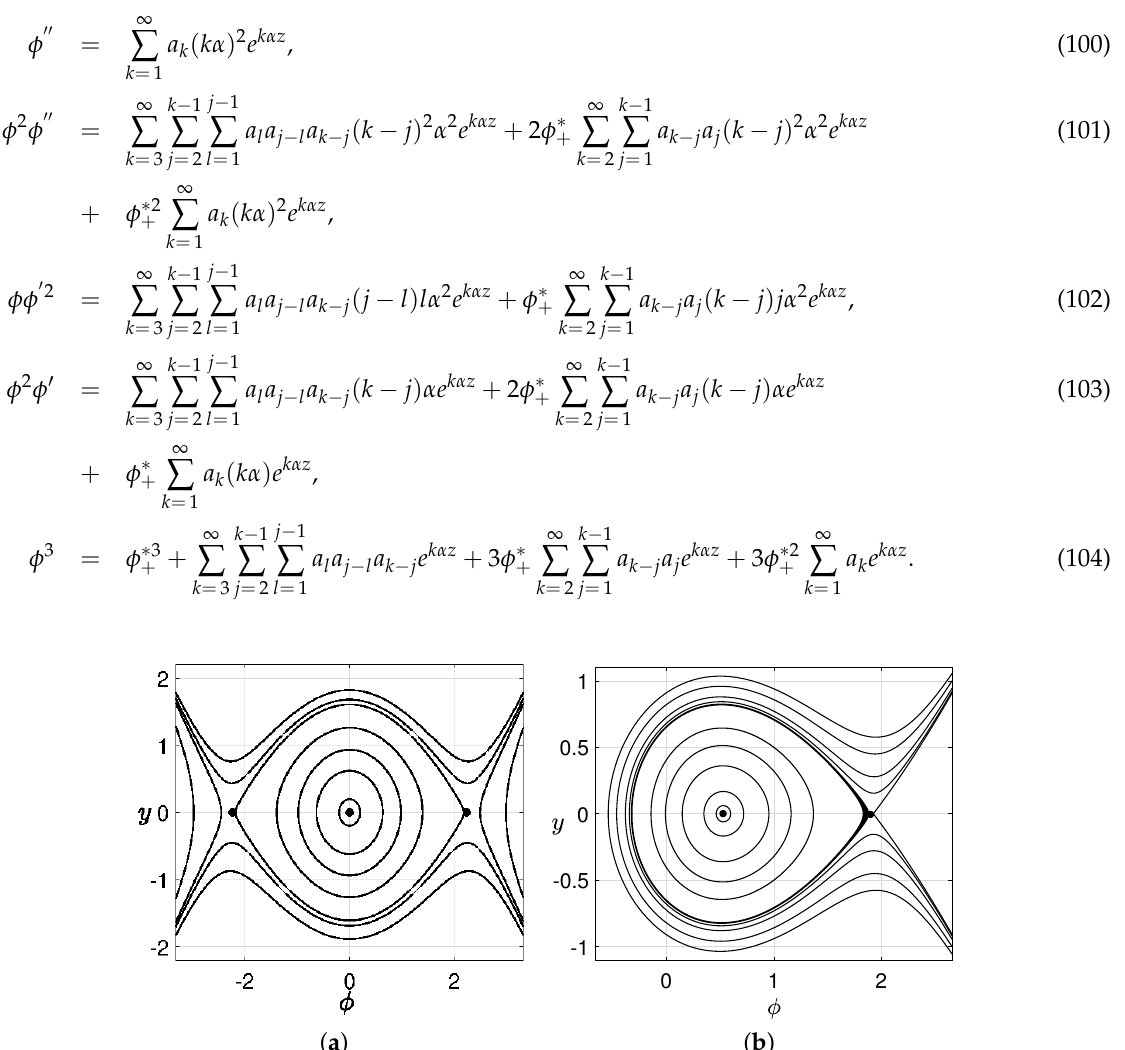
Figure 1. ( a ) Case g = 0: heteroclinic orbit joining the two saddle points E + ≡ ( φ ∗ ,0 ) and E − ≡ (cid:114) 3 v ( − φ ∗ ,0 ) with φ ∗ = ≈ 2.2361. The trivial equilibrium O is a center. The parameters are chosen 2 b as a = 0.12, b = 0.3, c = 0.2, v = 1 and g = 0. ( b ) Case g (cid:54) = 0: homoclinic orbit to the saddle equilibrium ( 1.9236,0 ) . The equilibrium ( 0.5297,0 ) is a center. The system also admits another saddle point ( − 2.4534,0 ) . The parameters are chosen as a = 0.12, b = 0.3, c = 0.2, v = 1 and g =